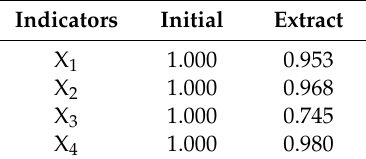
Table 6. Common factor